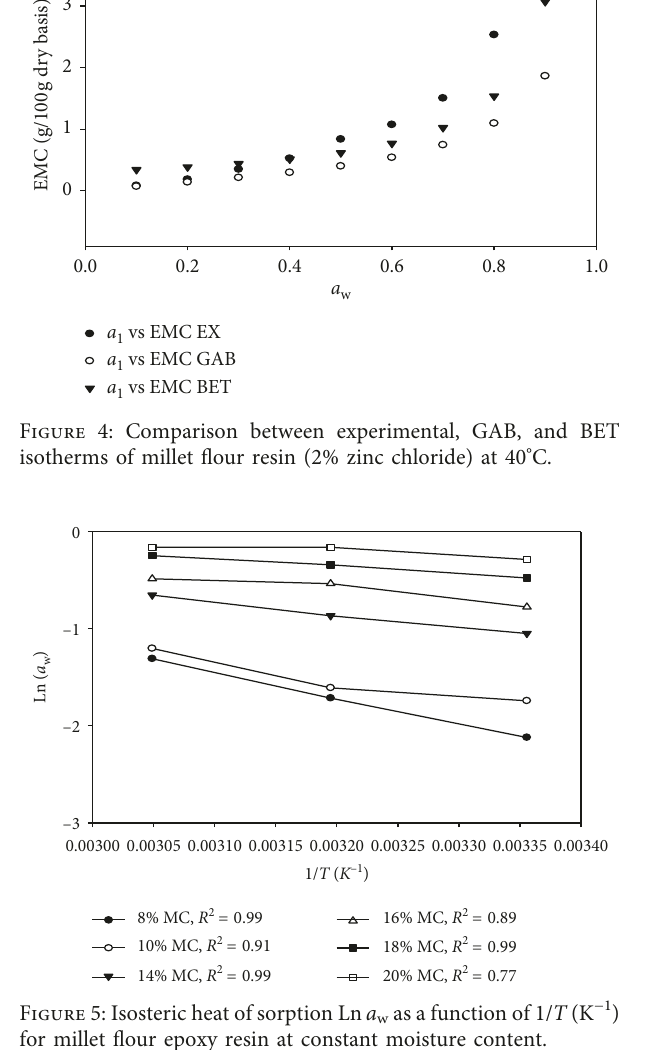
− 1 ) w as a function of 1/ T (K